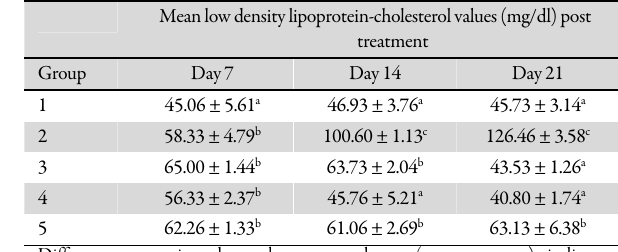
Table 6. The mean of low density lipoprotein-cholesterol values of alloxan induced diabetic rats treated with combinations of glibenclamide and aqueous extract of G. latifolium